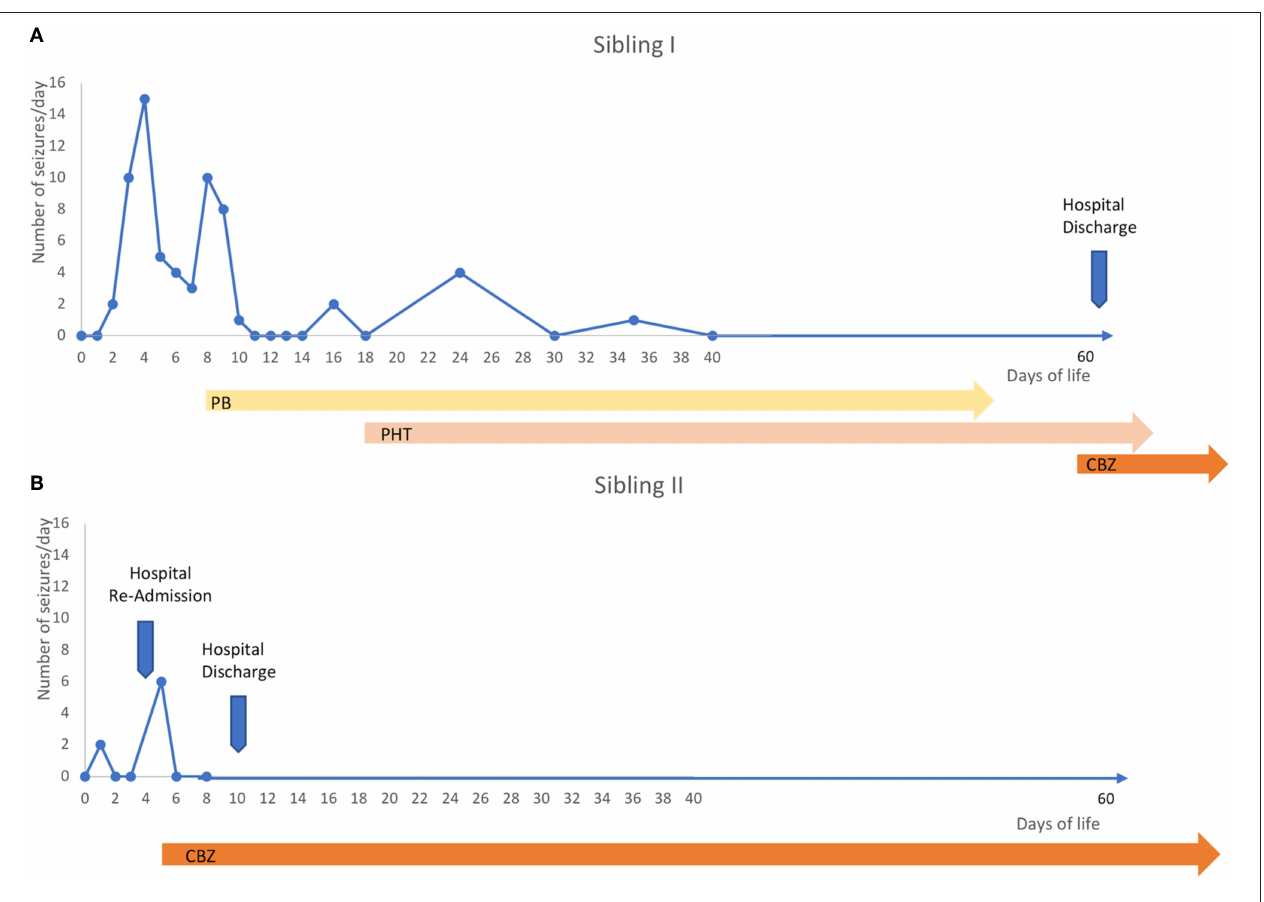
FIGURE 1 | Timeline. (A) The first sibling manifested sequential seizures from the second day of life and up to 15 seizures per day in the next days. He was firstly treated with phenobarbital with partial efficacy, so phenytoin was then trialed and it was effective, but seizures relapsed when blood levels were low due to difficulties in maintaining stable drug concentrations in the chronic stage, especially with oral use, so many blood tests were needed to check blood concentrations. Carbamazepine was finally introduced (5 mg/kg twice) at 2 months of age, obtaining stable seizure control. (B) One year later, a second sibling was born and had a couple of doubtful paroxysmal events on the second day of life suspicious to be a seizure, so an EEG was performed, but it was normal, so she was discharged. Then, at home, new more clear and frequent events suggestive of seizures occurred, so she was again admitted and the VideoEEG monitoring demonstrated repetitive sequential seizures, so, she was treated with carbamazepine as first choice (5 mg/kg twice) with immediate full seizure control and just five days after she was